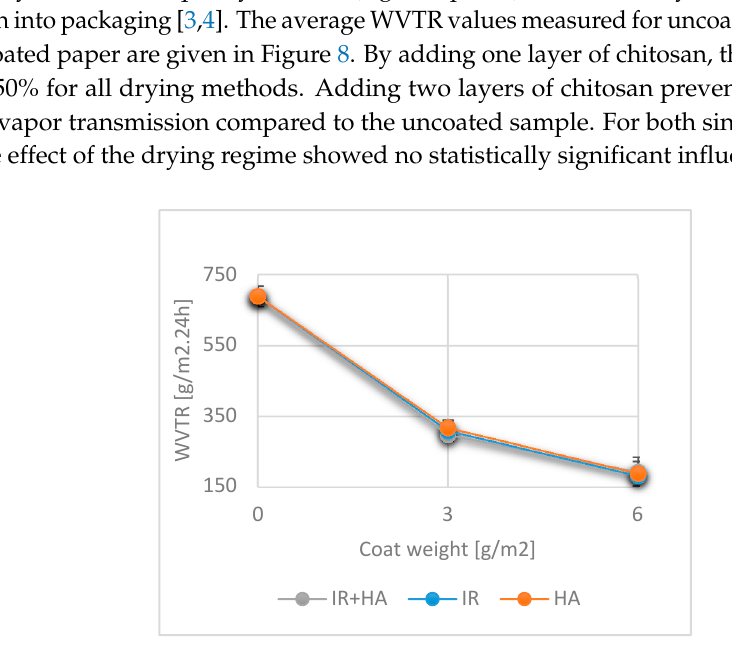
Figure 8. Water vapor transmission rates for uncoated paper and chitosan-coated paper. ( n = 6).